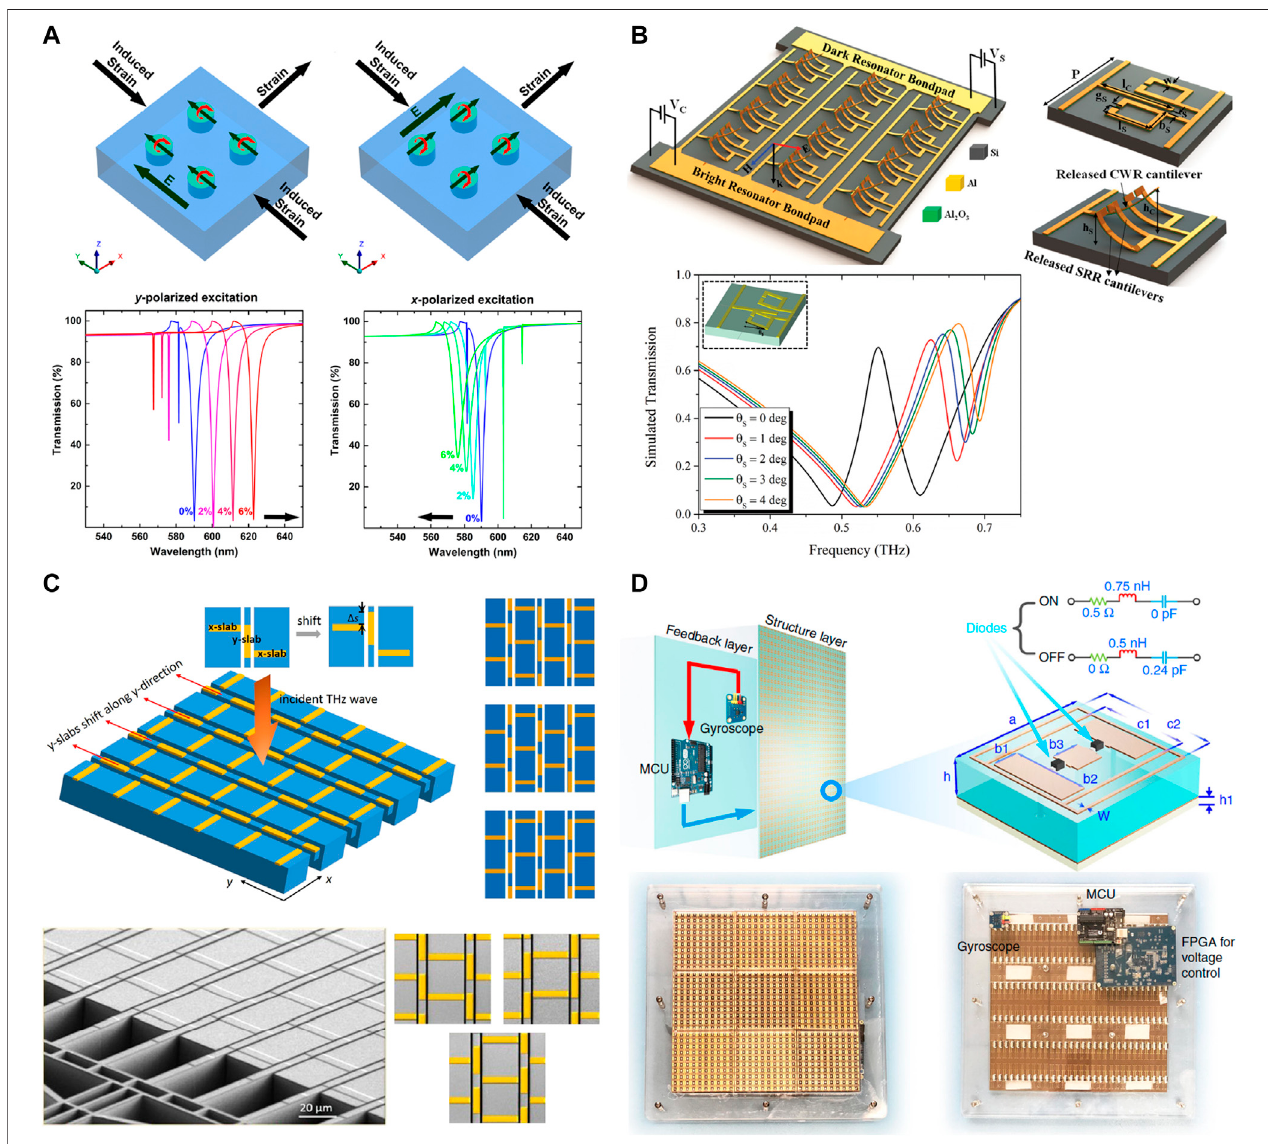
FIGURE7|(A) Stretchthe fl exiblemetasurfaceandrealizeremarkableresonanceshifts[45]. (B) MEMSmetasurfacewithcantileversallowstructurescanbetuned via electricity voltage. There are signi fi cant shifts of resonance wavelength as one end of un fi xed open ring resonators gradually warps [120]. (C) The recon fi gurable metasurface with suspended MEMS structure design and its three recon fi gurable states [182]. (D) Schematic diagram and actual appearance of programmable metasurface [103]. Figure reproduced with permission from: (A) , © 2016, American Chemical Society (ACS); (B) , © 2016, Wiley; (C) , © 2017, Nature Publishing Group (NPG); (D) , © 2019, Nature Publishing Group